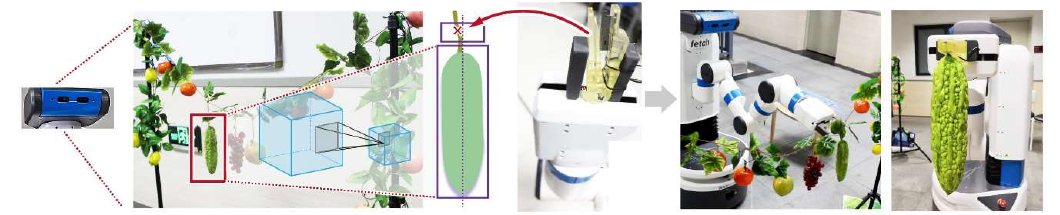
Figure 1. Architecture of the proposed harvesting robot.